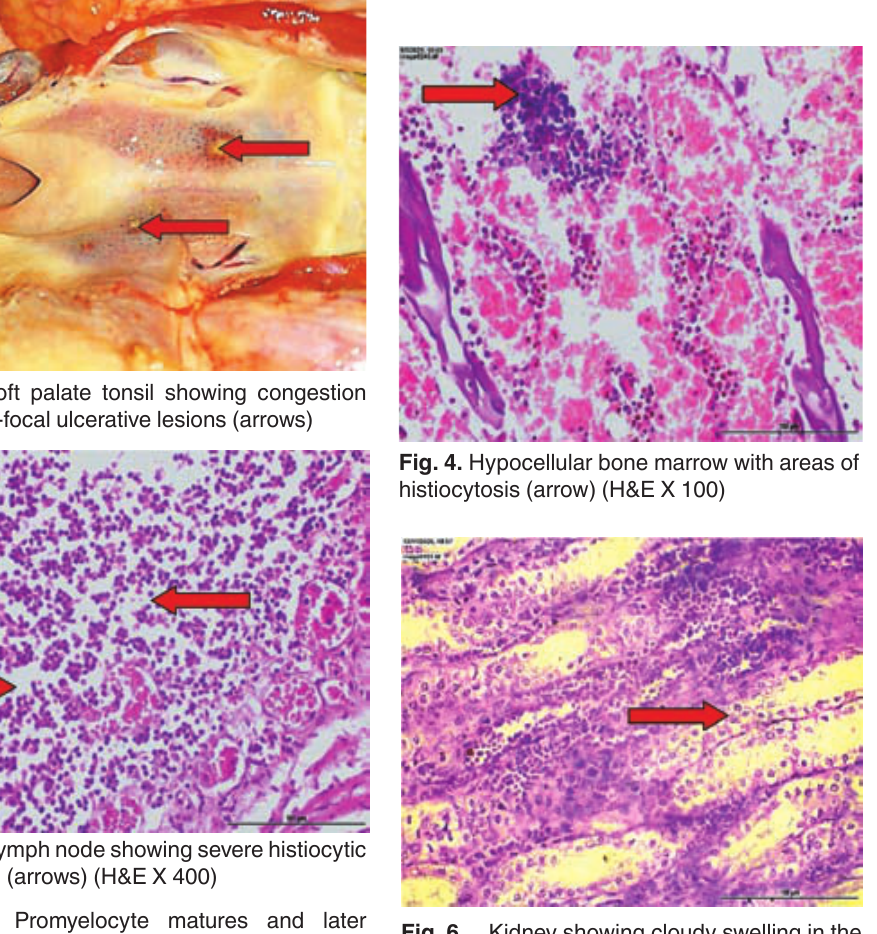
Fig. 6. Kidney showing cloudy swelling in the renal tubules (arrow) (H&E X